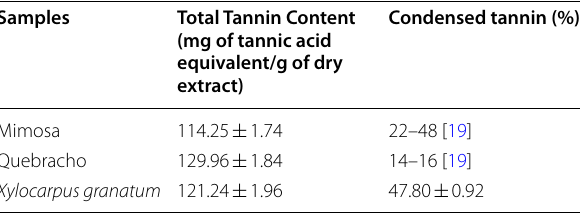
Table 4 Total tannin content and condensed tannin of Mimosa, Quebracho and Xylocarpus granatum